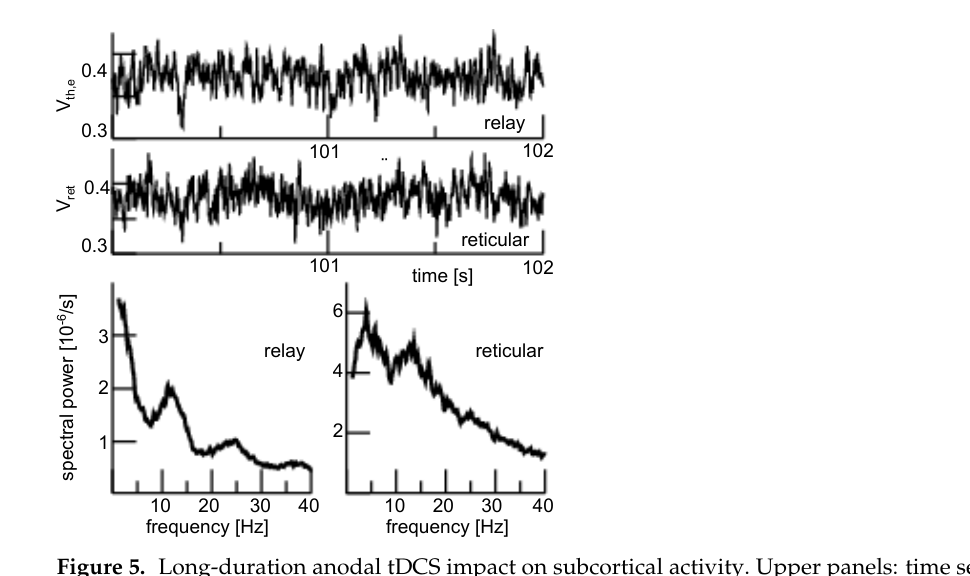
Figure 5. Long-duration anodal tDCS impact on subcortical activity. Upper panels: time series of simulated population activity for a-tDCS stimulation with f tDCS = 1.2. Lower panels: spectral power density distribution of relay and reticular population activity in the absence (dashed line, f tDCS = 1.0) and presence (solid line, f tDCS = 1.2) of a-tDCS